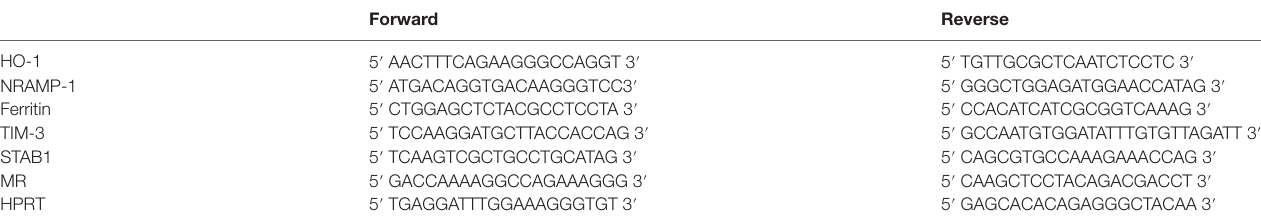
TaBle 1 | Primers used for real-time